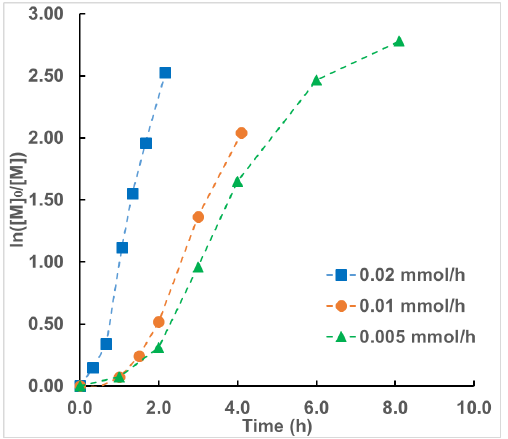
Figure 3. Kinetic plots of ln ([ M ] 0 / [ M ]) vs. time for ATRP of MA by continuous feeding of Cu(I) activators. [ MA ] 0 : [ MBrP ] 0 : [ CuBr 2 ] 0 : [ Me 6 TREN ] 0 = 100 : 1 : 0.005 : 0.01 at 60 ◦ C with 100mmol MA in 5mL of DMF; 0.04mmol CuBr/Me 6 TREN in 2mL MeCN was added in 2h, 4h, and 8h, respectively.